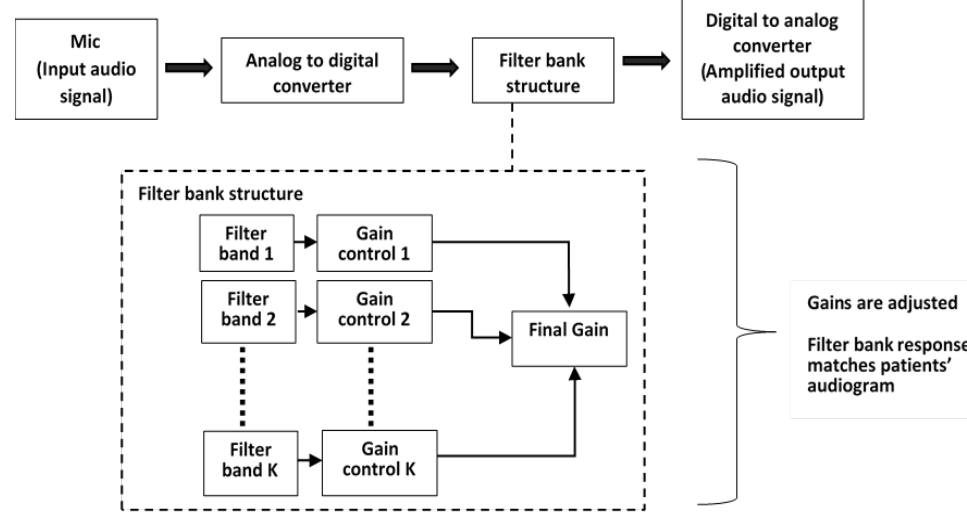
Figure 1. Hearing aid main stages.